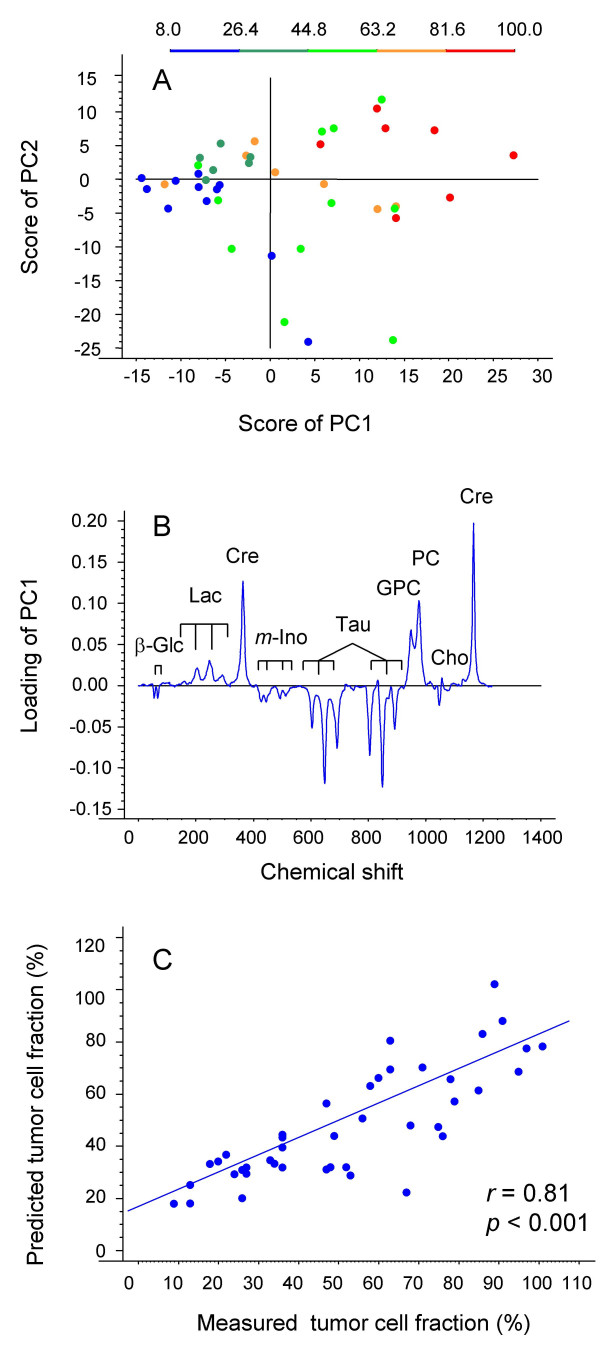
Score plot of first principal component (PC1) versus second principal component (PC2) from partial least square (PLS) regression analysis of tumor cell fraction to spin-echo spectral data (A), the corresponding loading profile of PC1 (B), and the predicted versus measured tumor cell fraction (C). In (A) and (C) each point represents the data of a single biopsy. In (A) the color code for tumor cell fractions (%) is shown. Spectral assignments are abbreviated in (B): β-Glc, β-glucose; Lac, lactate; m-Ino, myo-inositol; Cre, creatine; Tau, taurine; GPC, glycerophosphocholine; PC, phosphocholine; Cho, choline. The Pearson correlation coefficient and p-value are marked in (C). Total residual y-variance and root mean square error of prediction were minimised by retaining 2 PCs in the model. These two PCs accounted for 45% of the total x-variation, and 66% of the total y-variation.